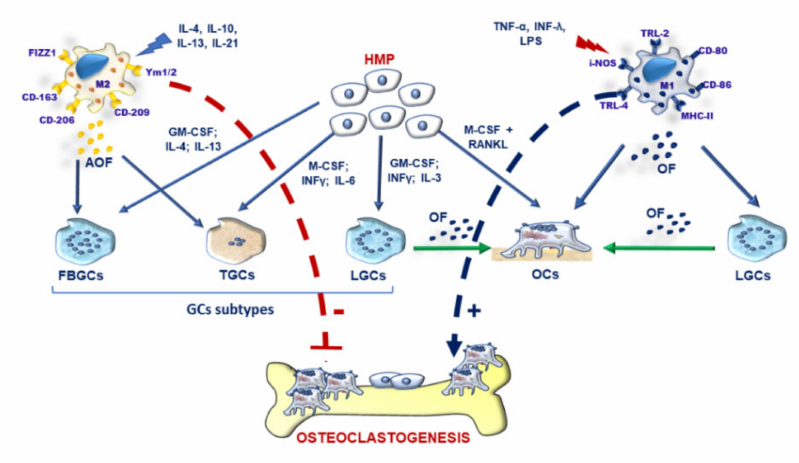
Figure 4. Graphical representation of factors modulating osteoclasts (OCs) and giant cells (GCs) formation. M2 macrophages, induced by IL-4, IL-10, IL-13 and IL-21, can release anti-osteoclastogenic factors (AOF), which promote foreign-body giant cells (FBGCs) and Touton giant cells (TGCs). Hematopoietic monocyte / macrophages precursors (HMP) under (i) GM-CSF, IL-4 and IL-13 can originate FBGCs; (ii) M-CSF, INF- γ , and IL-6 stimuli can induce Touton cells (TGCs); and (iii) GM-CSF, INF- γ and IL-3 can produce Langhans giant cells (LGCs). FBGCs, TGCs and LGCs represent the main three subtypes of GCs, displaying distinct histological and functional features. HMP can originate mature OCs after M-CSF and RANKL stimulation. M1 macrophage, induced by TNF- α , LPS and INF- λ , release osteoclastogenic factors (OF), which promote OCs and LGCs. LGCs can release OF, which in turn support the OCs di ff erentiation. M2 macrophages inhibit osteoclastogenesis by releasing AOF (red arrow). M1 macrophages promote osteoclastogenesis via the release of (blue